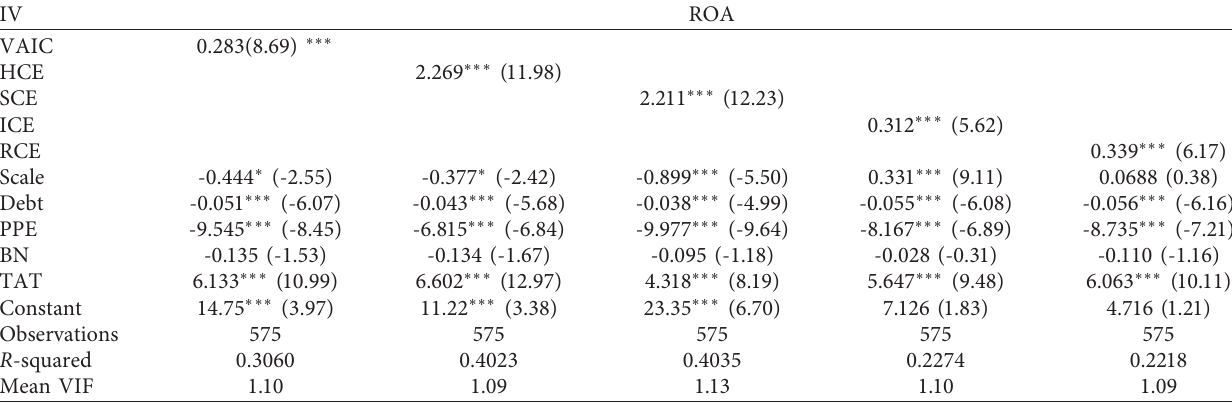
Table 5: Influence of IC and its constituent elements on firm